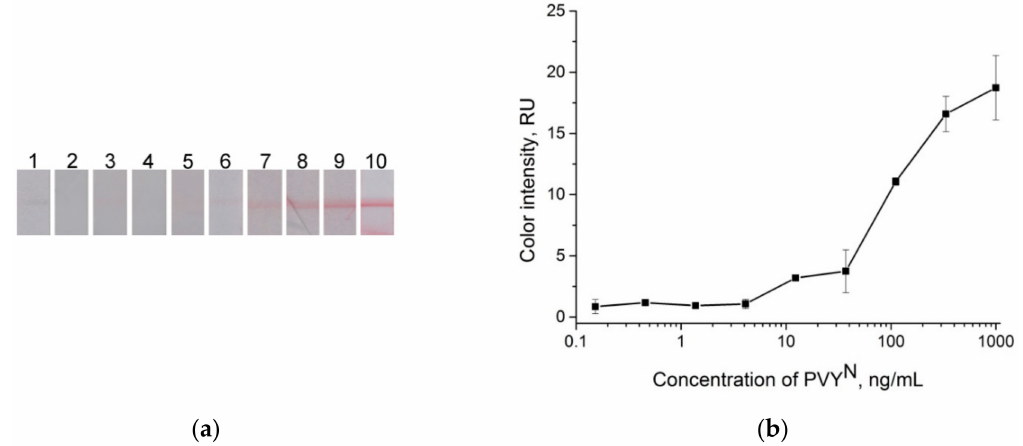
Figure 7. LFIA in buffer. ( a ) Lateral flow strips after testing of the samples containing PVY N , test strip 1 is the negative control (0 ng · mL − 1 ), and test strips 2–10, PVY N concentration: 0.15 ng · mL − 1 , 0.46 ng · mL − 1 , 1 ng · mL − 1 , 4 ng · mL − 1 , 12 ng · mL − 1 , 37 ng · mL − 1 , 111 ng · mL − 1 , 333 ng · mL − 1 , and 1000 ng · mL − 1 , respectively. ( b ) Dependence of color intensity of the test zone on the PVY N